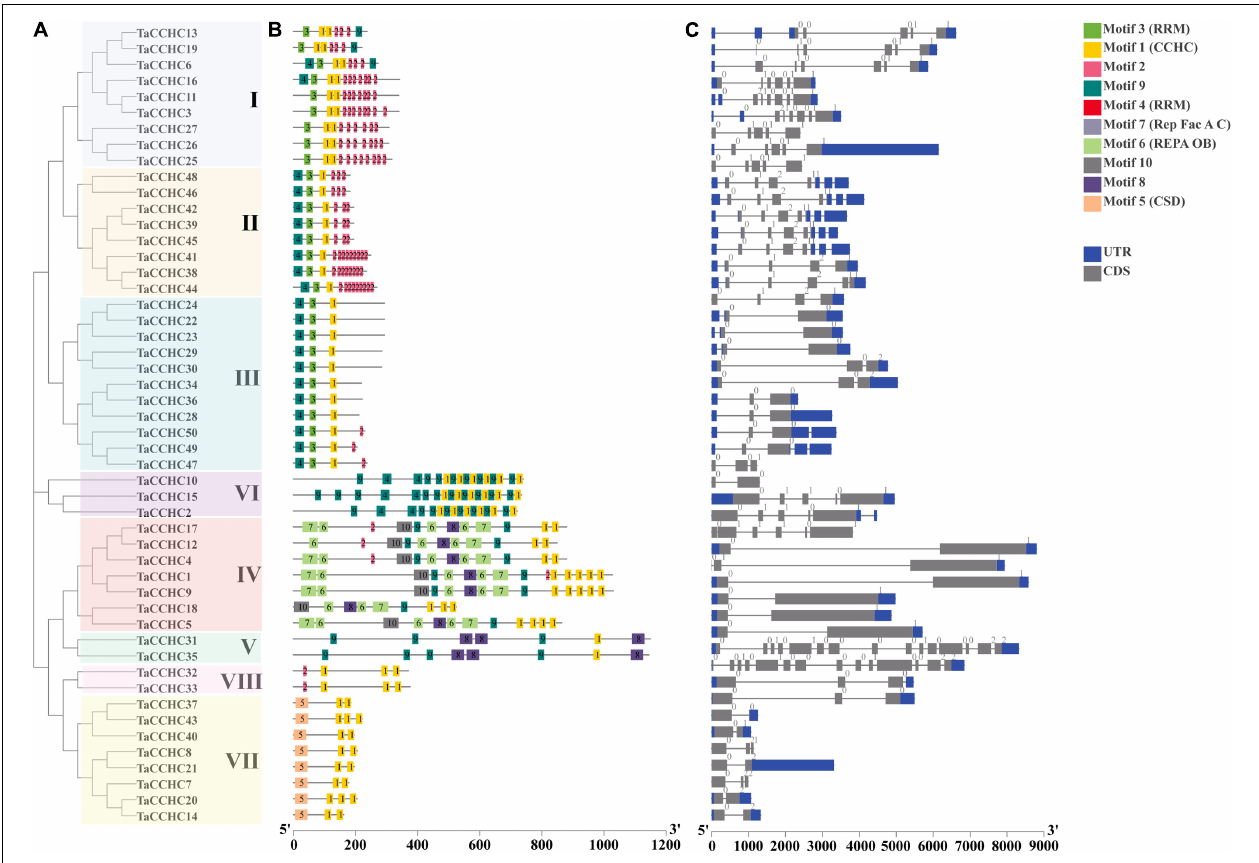
FIGURE 3 | Comparative analyses of the phylogenetic relationships, protein conserved motifs, and gene structures of CCHC-ZFP family in wheat. (A) Phylogenetic tree of 50 TaCCHC-ZFPs was constructed by using MEGA 7.0. Each group was marked by a different color. (B) Motif composition of wheat CCHC-ZFPs. MEME was adopted to identify the conserved motifs of the TaCCHC-ZFPs. The motifs are displayed by different-colored boxes with the corresponding number in the center of the motifs. (C) Gene structures of TaCCHC-ZFP genes. The black lines represent the introns, while the blue and gray boxes represent the untranslated regions (UTRs) and exons, respectively. The numbers represent the phases of corresponding